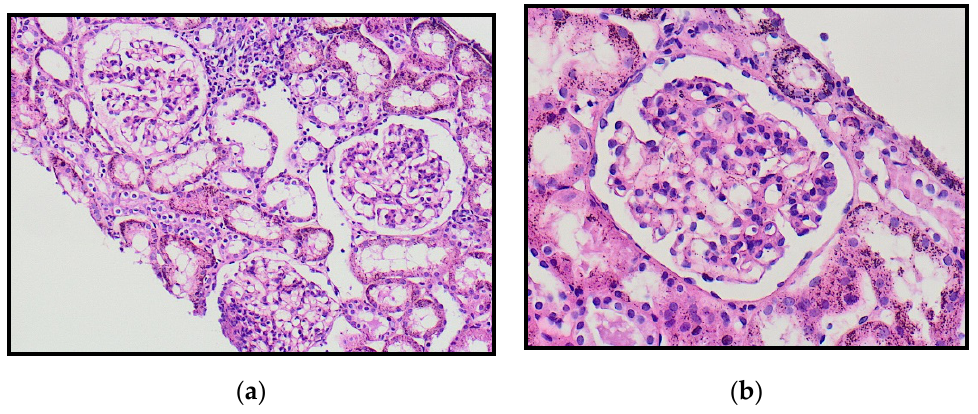
Figure 4. Renal biopsy from a 4-year-old boy with IgA vasculitis with renal impairment, the glomeruli showing mesangial proliferation with no crescent formation. ( a ) Low power and ( b ) high power.